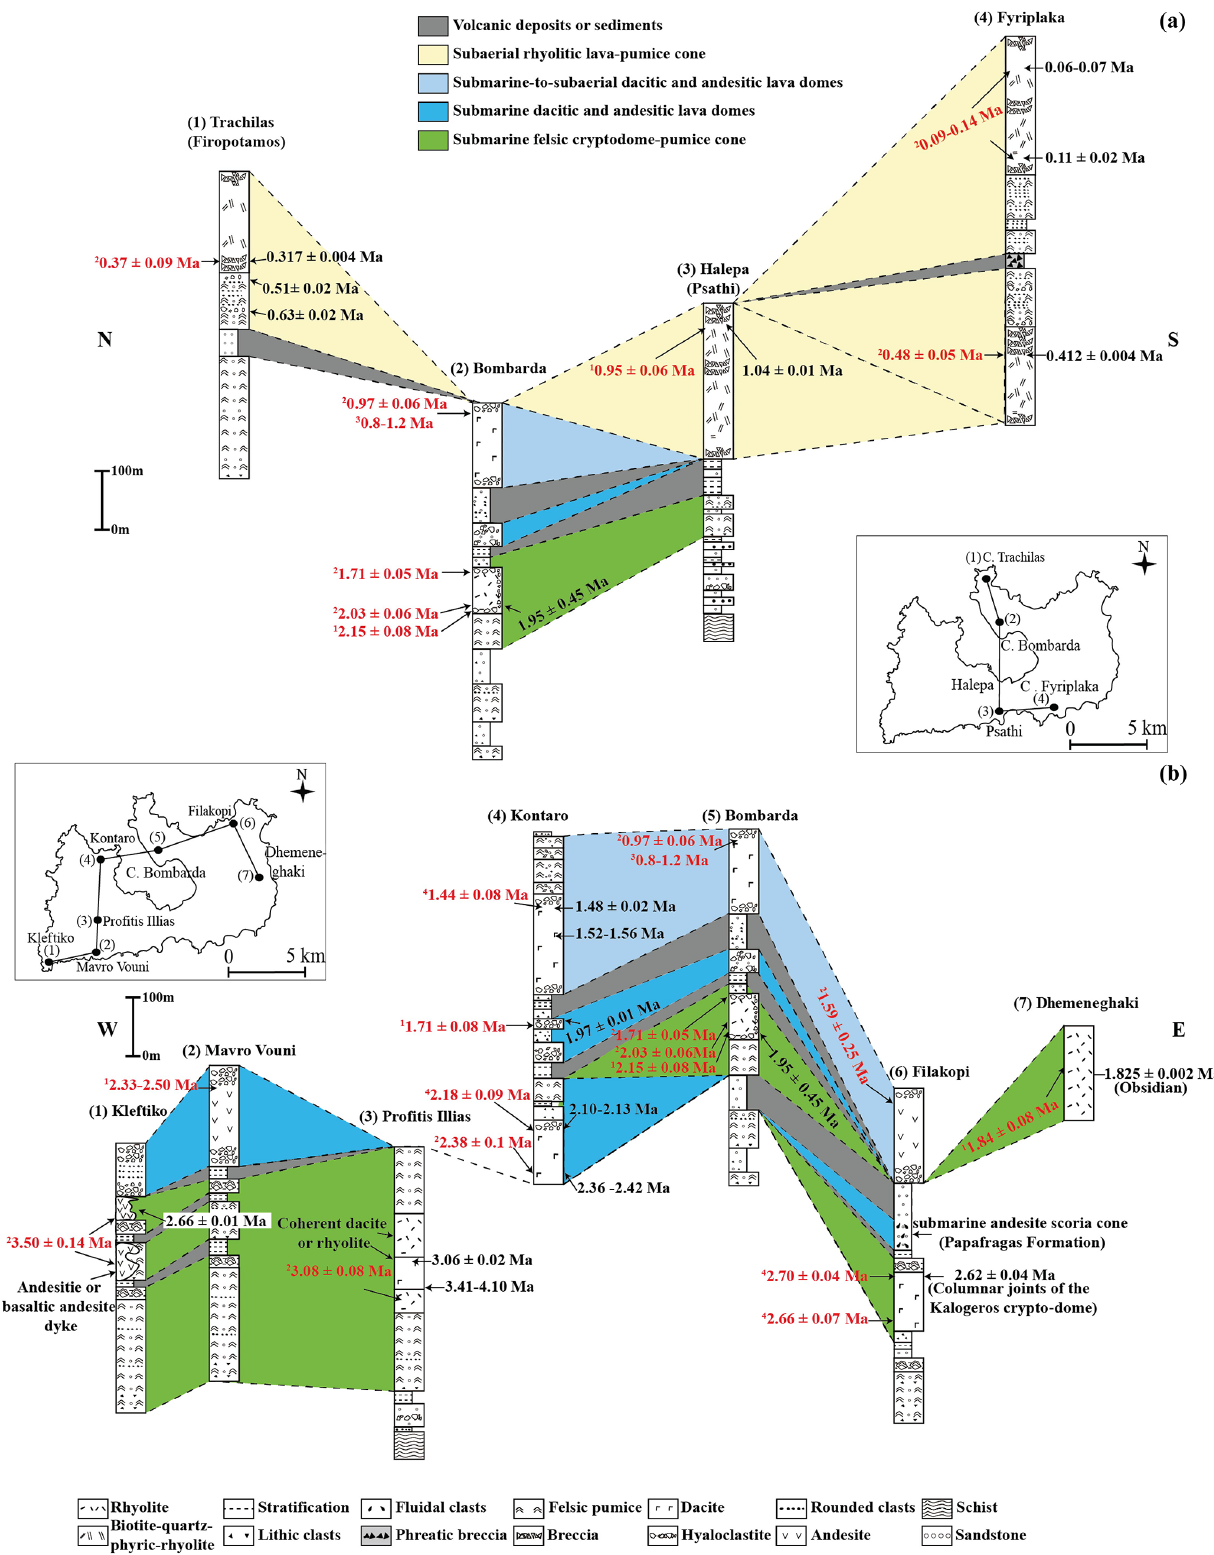
Figure 13. Nine selected stratigraphic columns covering the (a) young ( < 1.4Ma) and (b) old ( > 1.4Ma) volcanic deposits of Milos modified after Stewart and McPhie (2006), except for (7) Dhemeneghaki. Age data in black are from this study and those in red are from (1) Angelier et al. (1977), (2) Fytikas et al. (1976, 1986), (3) Matsuda et al. (1999) and (4) Stewart and McPhie (2006).